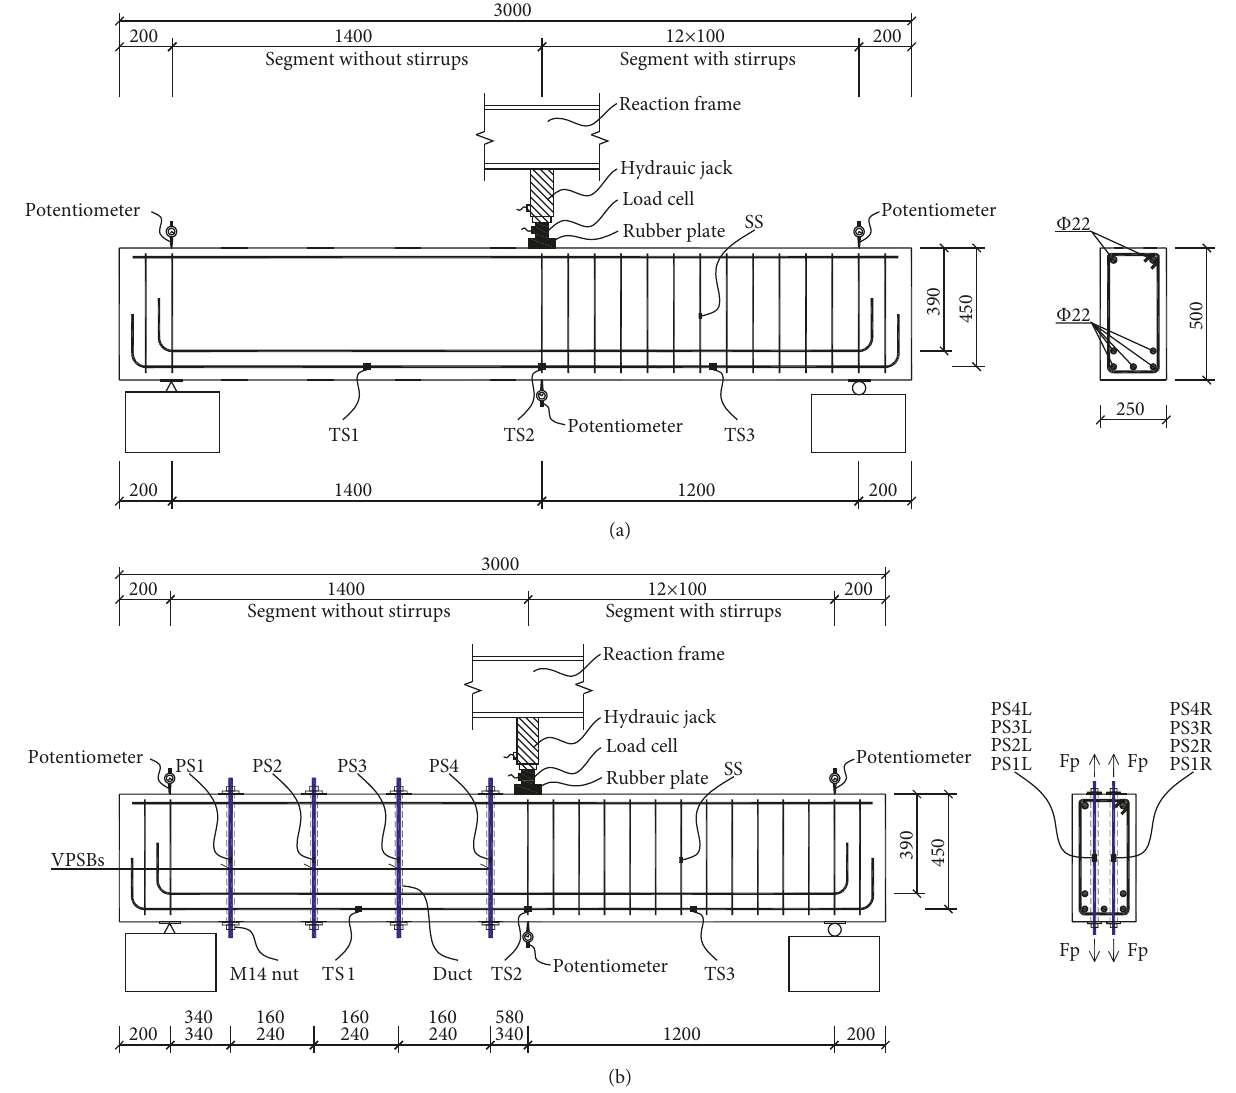
Figure 1: Geometry and arrangement of specimen reinforcement (units: